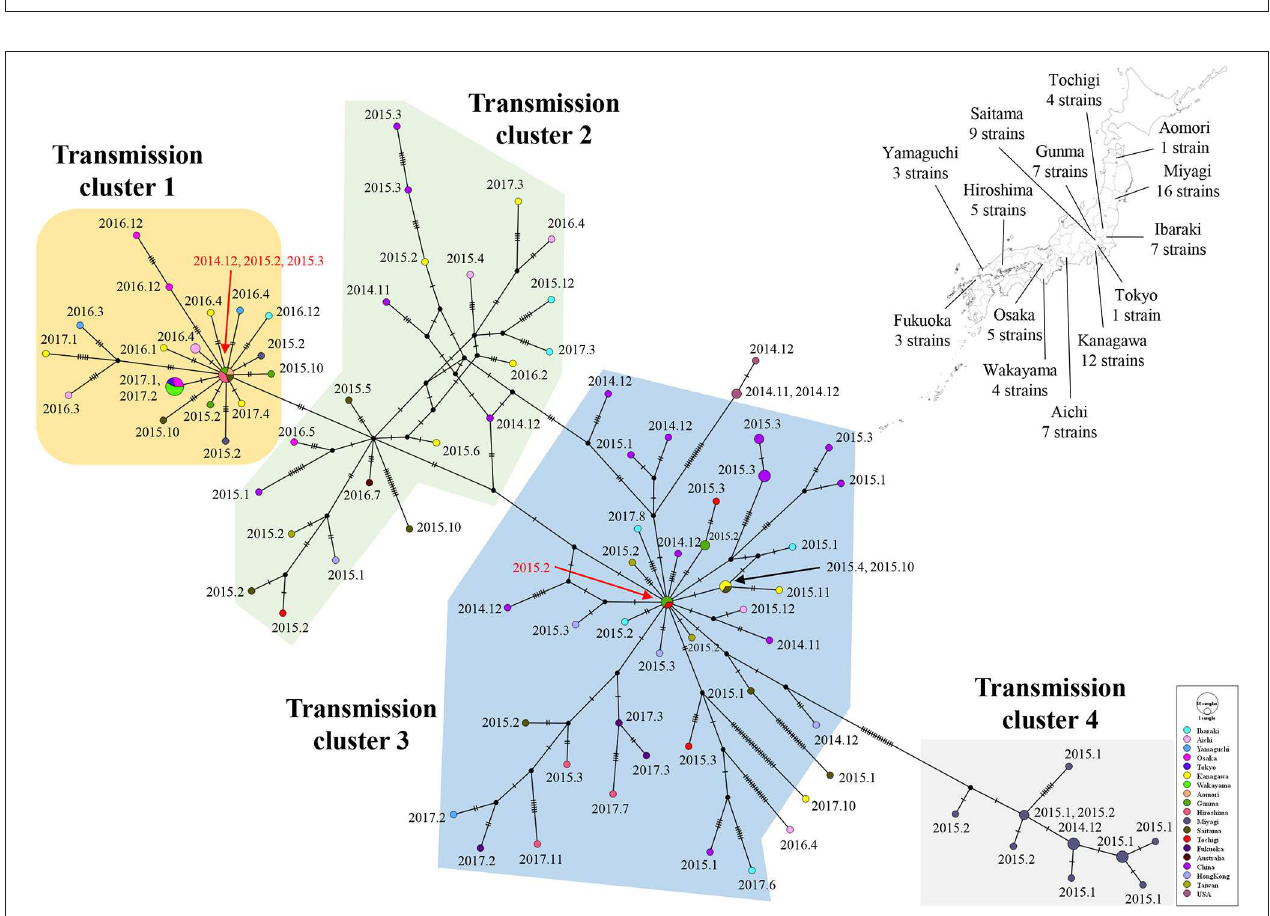
FIGURE 6 | (chain B). Amino acid substitutions between GII.P17 and GII.P4 (A) or within the GII.P17 clusters (B,C) that are close to the interface between monomers and to the active site cleft are colored blue with the positions under the order of alignments, whereas the substitutions distant from these regions are shown in yellow. The residues of active sites for RNA replication are colored red. The purple quadrilaterals highlight the region of the active site cleft.